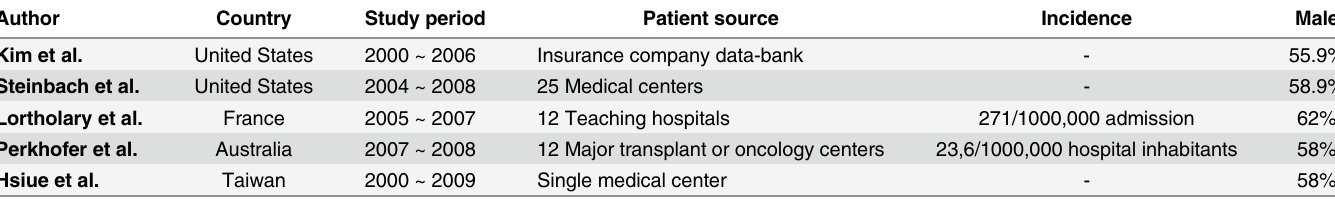
Table 3. Comparison of large epidemiological studies on invasive